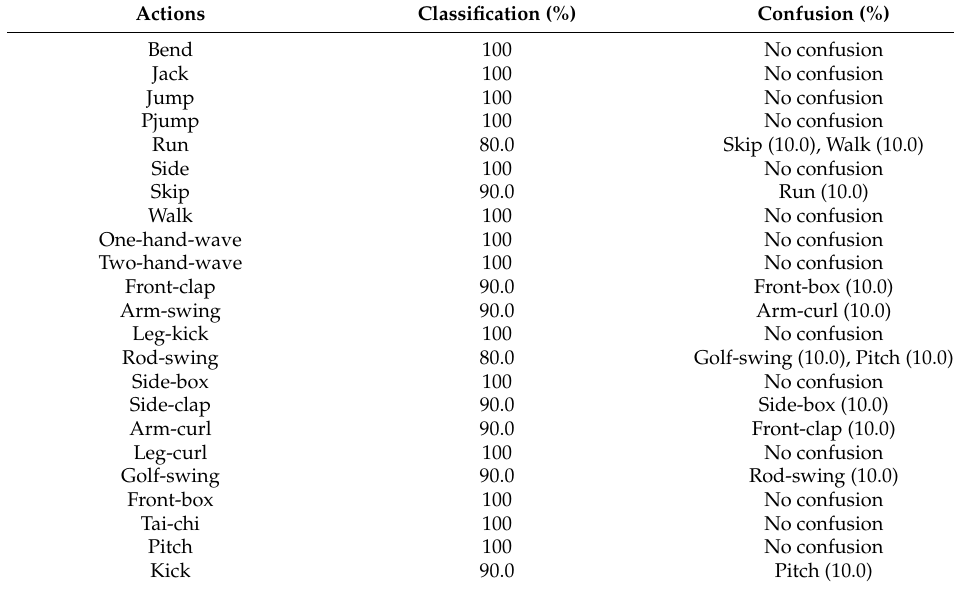
Figure 5. Confusion matrix on DHA dataset. Table 4. Class-specific accuracy on DHA